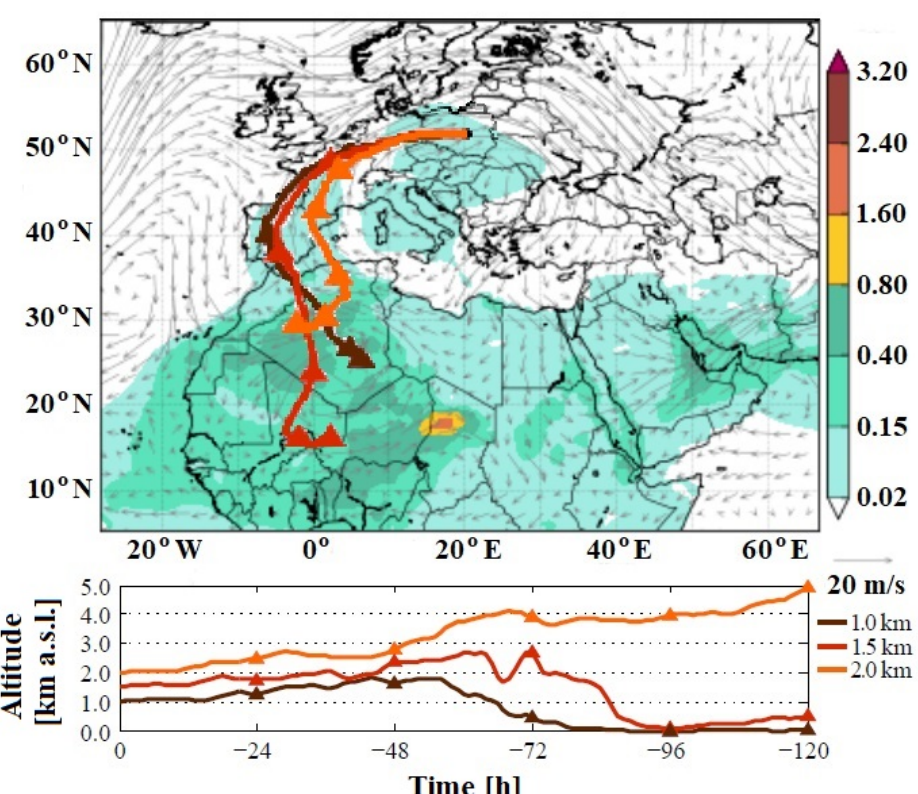
Figure 3. Aerosol optical depth at 550 nm (color bar) of mineral dust forecast with superimposed backward trajectories 25 February 2021. BSC-DREAM8b model run at 12:00 UTC valid for 12:00 UTC. HYSPLIT model calculations for 120 h, starting at 12:00 UTC at 1.0, 1.5, and 2.0 km a.s.l. The forecast shows that the obtained air masses from North Africa likely contained mineral dust, whereby air masses likely mixed with each